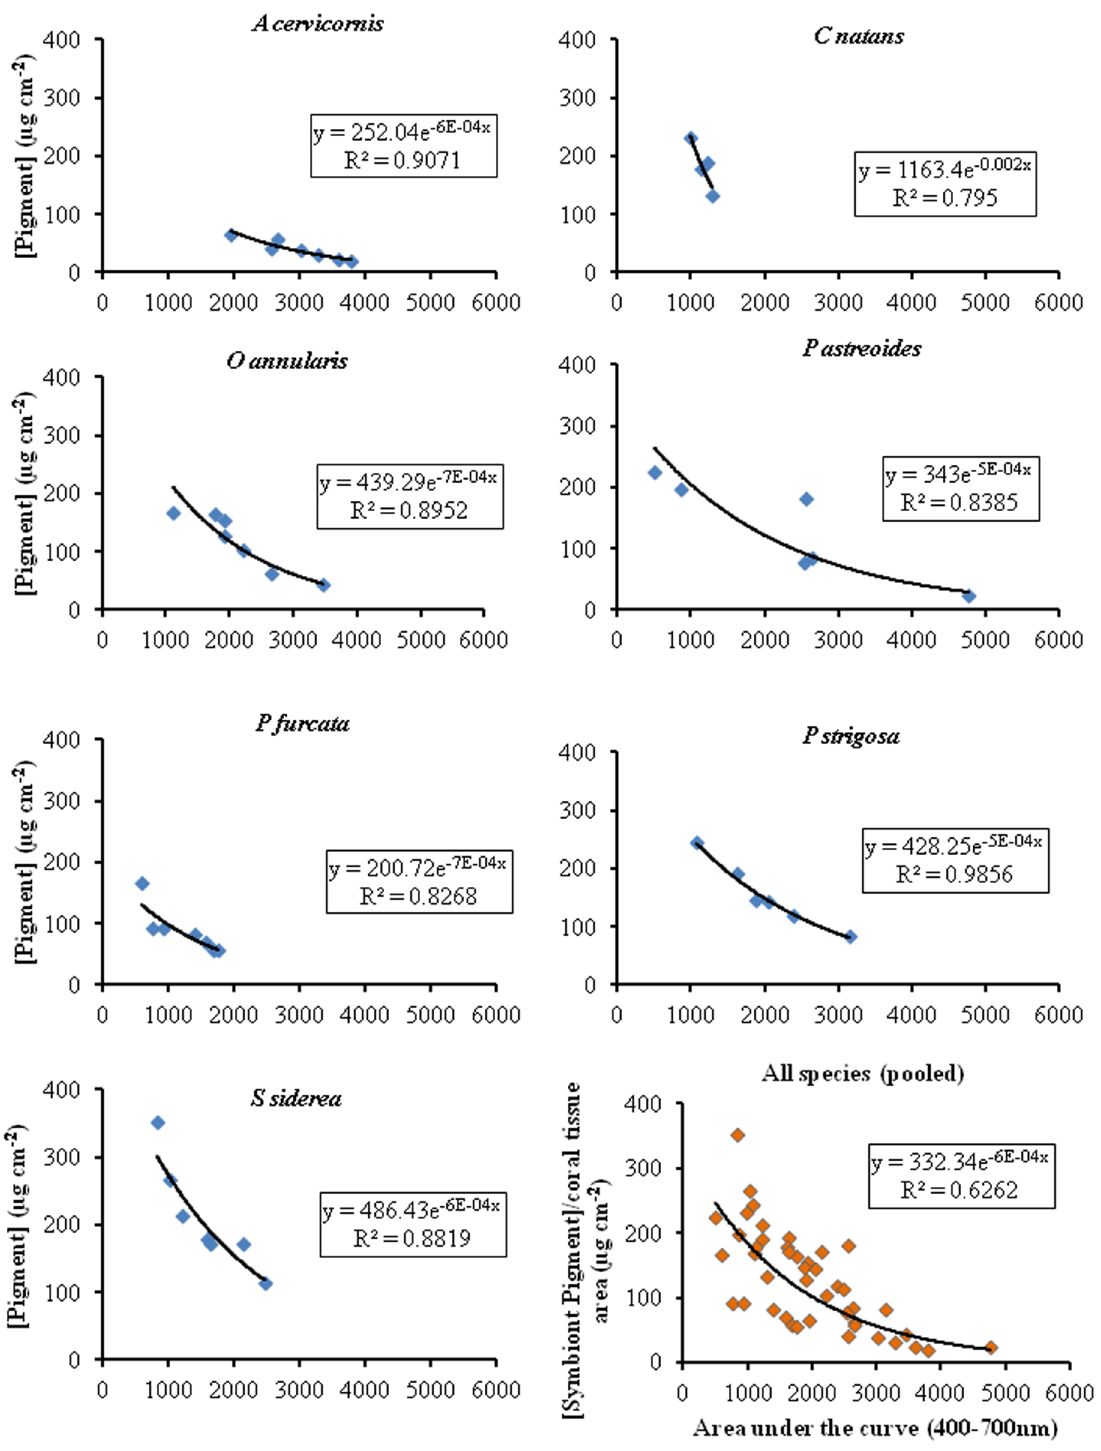
Fig 6. Relationship between the area under the reflectance curve and total symbiont pigment concentration. The x-axis represents the integration of the reflectance curve from 400 – 700 nm. The lower right graph shows the pooled data from all seven species.